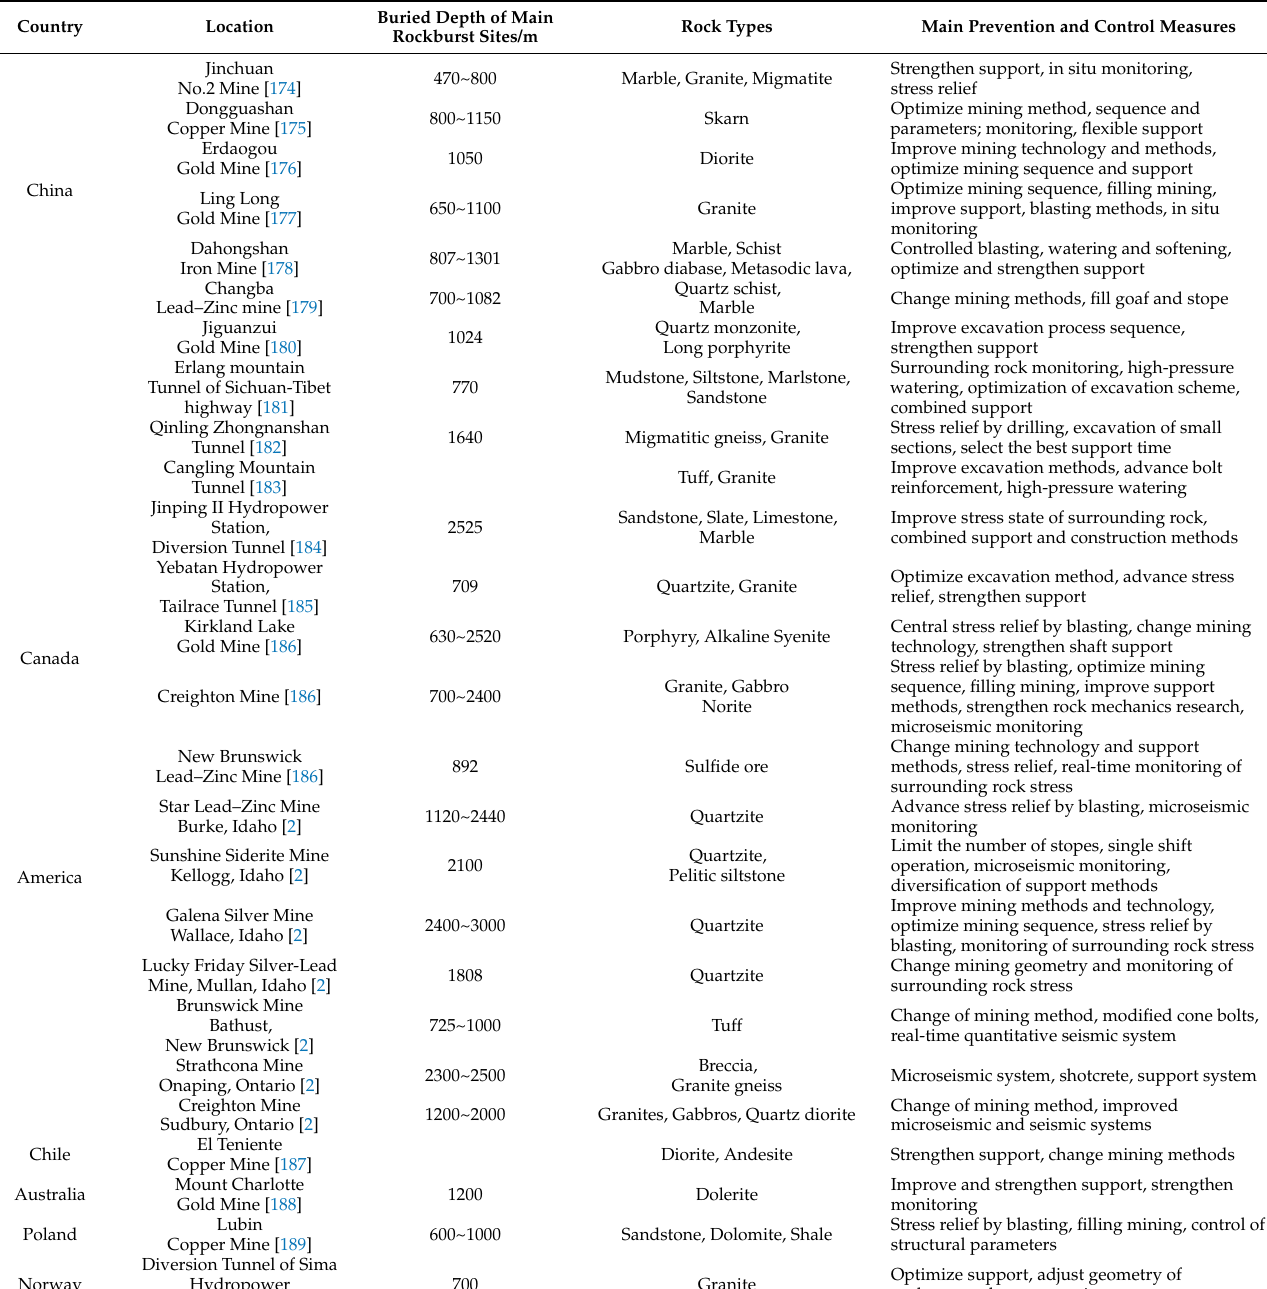
Table 7. Worldwide survey of rockburst prevention and